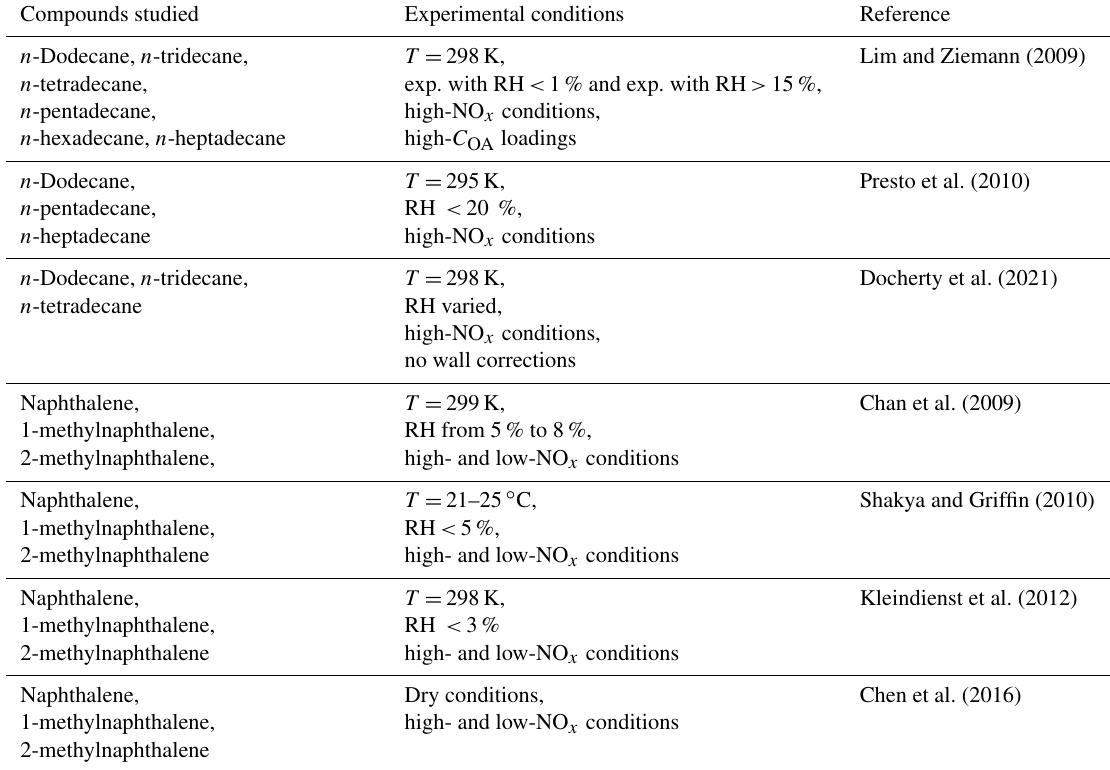
Table 2. Experimental smog chamber studies utilized in this work to estimate the mass-based stoichiometric yields of the individual IVOCs. Compounds